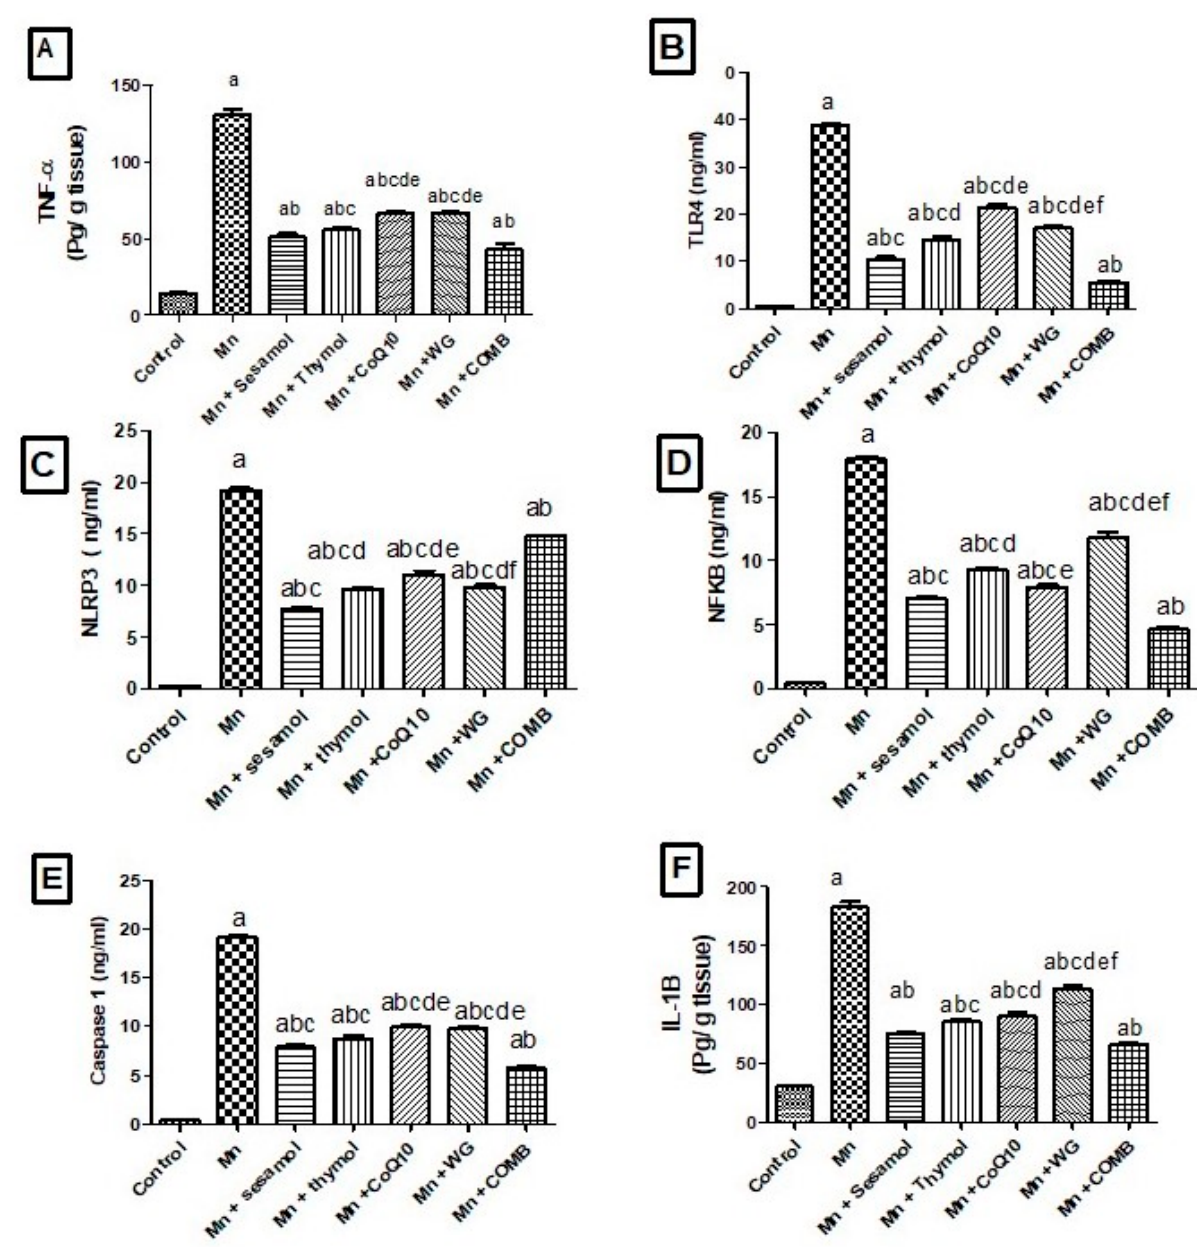
Figure 6. Effects of sesamol, thymol, CoQ10, wheat grass, or their combination on brain inflammatory markers in rats treated with MnCl 2 . ( A ) tumor necrosis factor alpha, ( B ) TLR4, ( C ) NLRP3, ( D ) NF- κ B, ( E ) Caspase-1, and ( F ) IL-1 β . Values are means of 8 rats ± S.E.M, as compared with control (a), Mn (b), COMB (c), sesamol (d), thymol (e), and CoQ10 (f) groups. One-way ANOVA with posttest Tukey’s multiple comparison assessed the statistical differences between the various groups, p -value < 0.05.